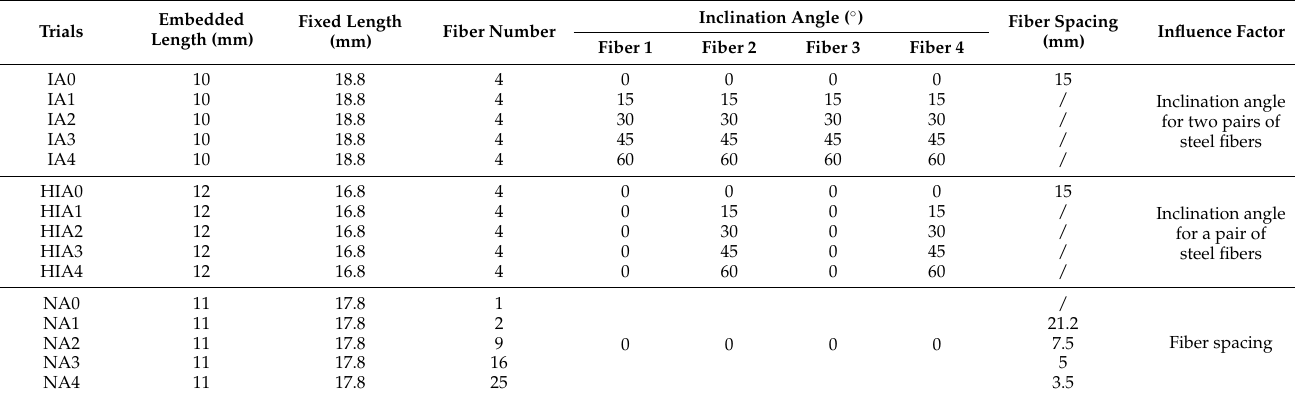
Table 2. Details of the specimen designed for the pullout test.